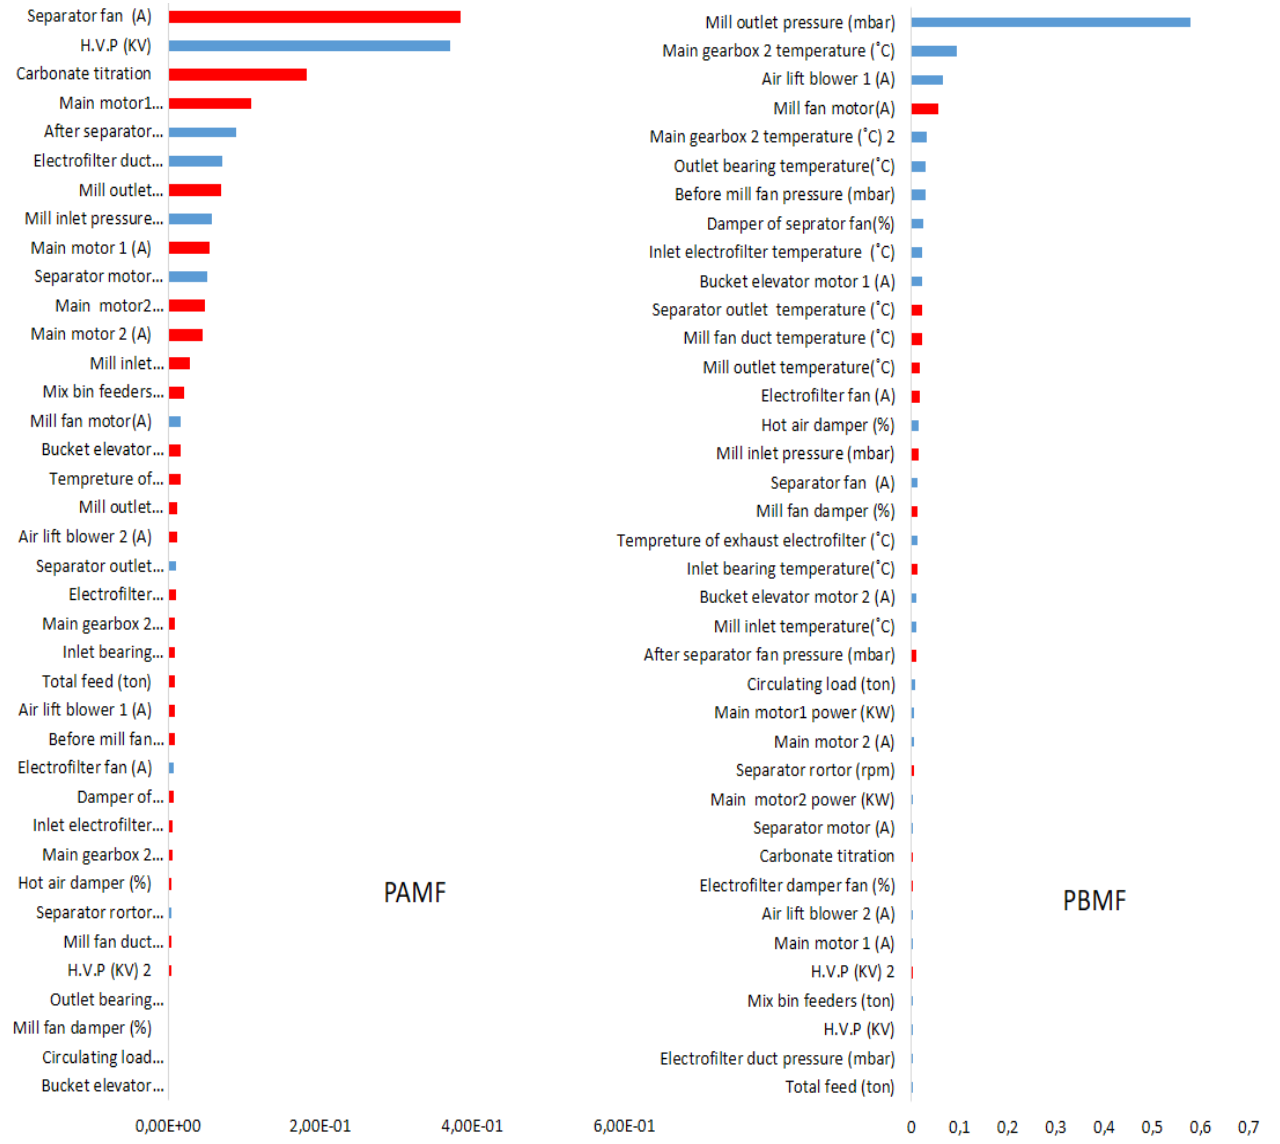
Figure 2. Variable importance measurement for ranking variables. Pearson correlation: Positive (blue), negative (red).